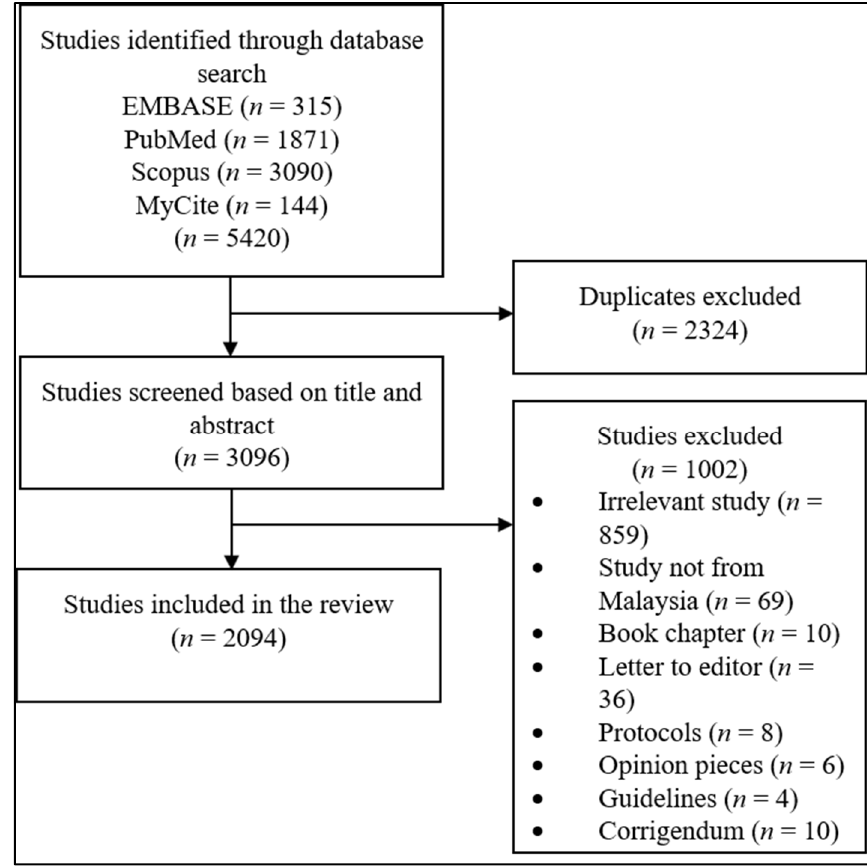
Figure 1. Study flowchart of the data retrieval process .